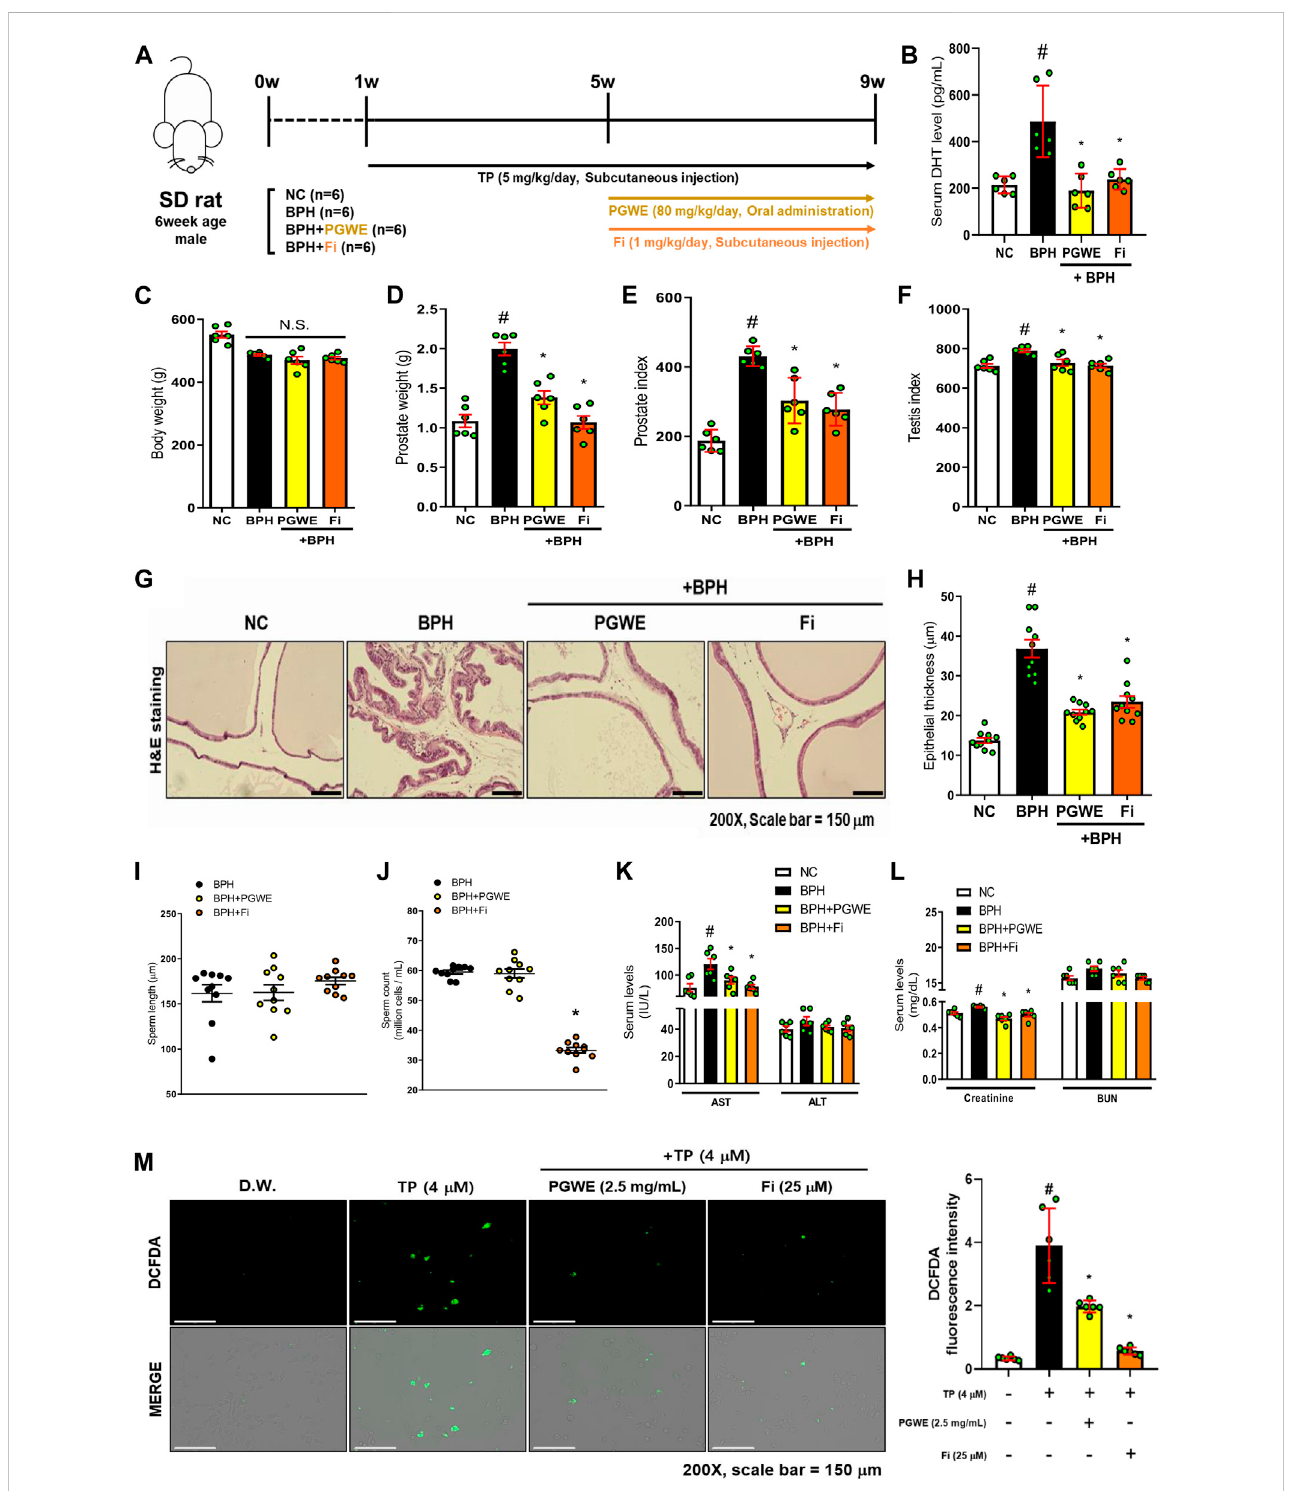
FIGURE 2 PGWE alleviates pathological signs of BPH in TP-induced BPH rats (A) Experimental scheme of in vivo study (B) Serum DHT levels were analyzed using ELISA kits (C) Body and (D) prostate weights were assessed (E) Prostate index was calculated by prostate weight (mg)/body weight (100 g) (F) Testis index was calculated by testis weight (mg)/body weight (100 g) (G) H and E staining analysis was performed using prostate tissues of TP-induced BPH rats (magni fi cation×200,scalebar150 µm) (H) BasedonHandEstaining,theepithelialthicknesswasmeasuredusingImageJsoftware (J) Numberofsperm extracted from theepididymis of rats and (I) length ofsperm werecalculated using ImageJ software (K, L) Serum levels ofAST, ALT, creatinine, and BUN were measured (M) ROS levels were detected by fl uorescence microscopy after DCFDA staining in TP-treated RWPE-1 cells. All data are expressed as mean ± SEM of independent experiments. Statistical differences were calculated by one-way ANOVA with post-hoc Tukey ’ s test. # p < 0.05 vs NC groups or D.W.-treated RWPE-1cells; p p < 0.05vsBPHgrouporTP-treatedRWPE-1cells.NC,normalcontrol;BPH,benignprostatichyperplasia;TP,testosteronepropionate;PGWE, Panax ginseng C. A. Meyer water extract; Fi, fi nasteride; D.W., distilled